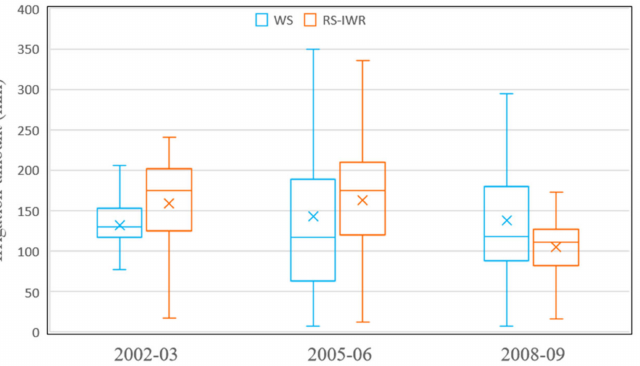
Figure 6. Distribution of observed irrigation water use (WS) and remotely sensed irrigation water requirements (RS-IWR) at field level for the three seasons.